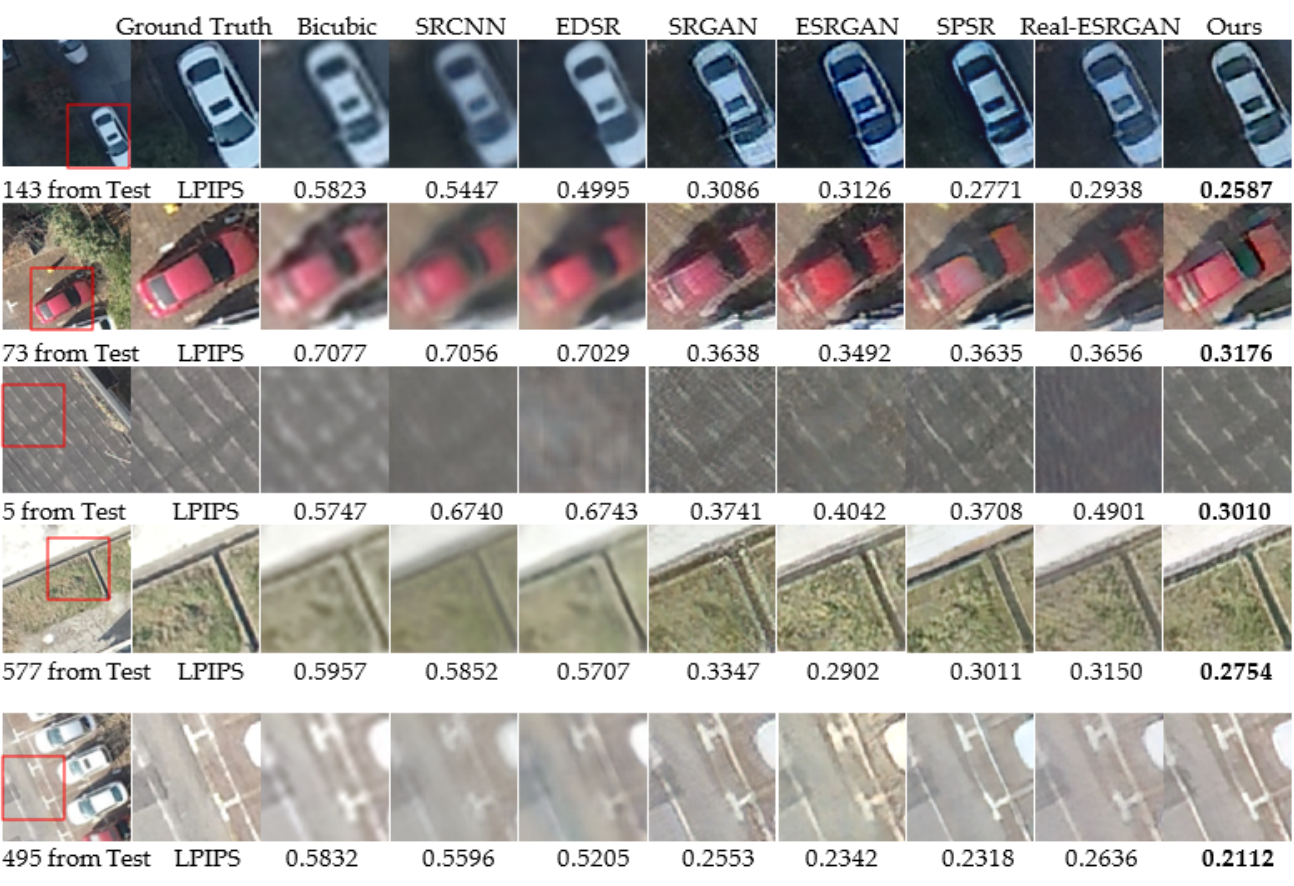
Figure 4. Visualisation effects of reconstructed images by different methods and their corresponding LPIPS values. The best performance in bold.